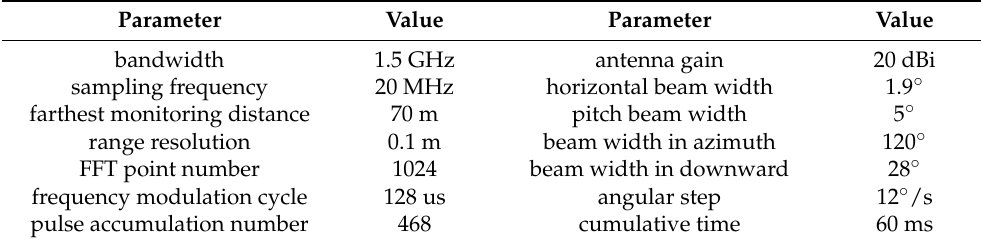
Table 1. Parameters of the LFMCW radar